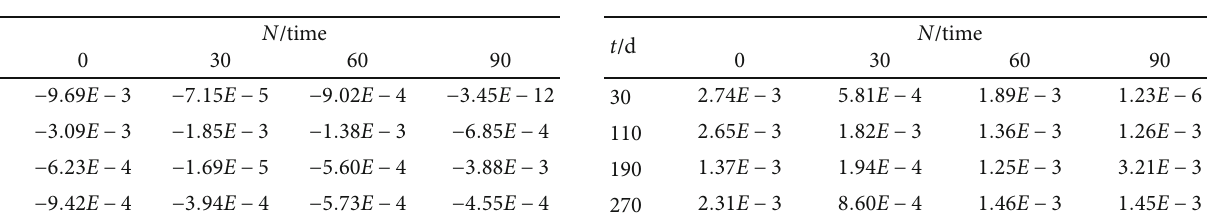
ff erent freeze-thaw cycles 1 of di